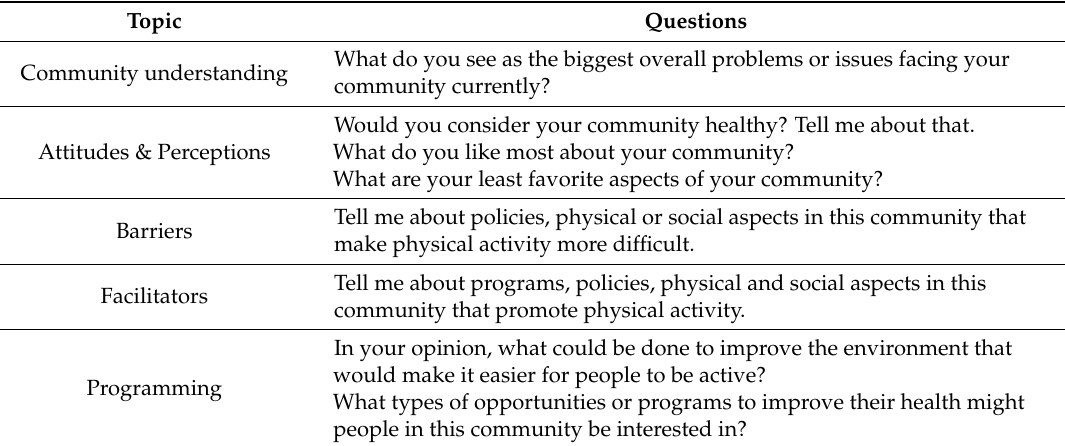
Table 3. Interview guide questions related to physical